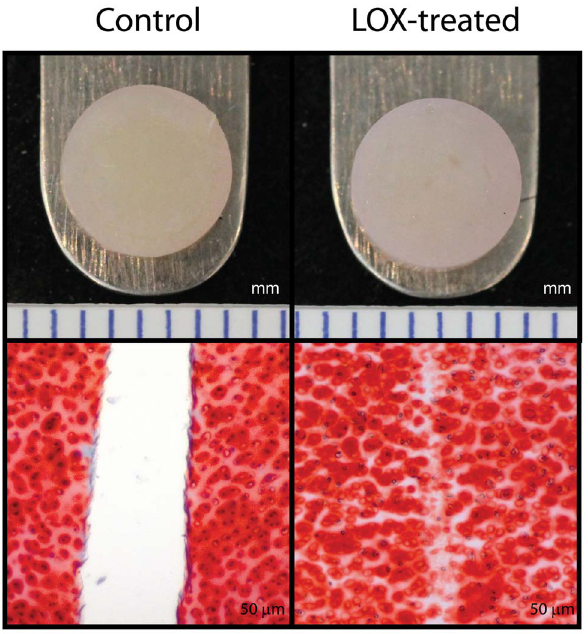
Figure 4. Gross morphology and histology of explant/explant assemblies. Neither control nor LOX-treated native-to-native assem- blies displayed grossly visible gaps when removed from culture (top row). However, gaps can be seen after histological processing using picrosirius red in the control group, unlike the LOX-treated group (bottom).